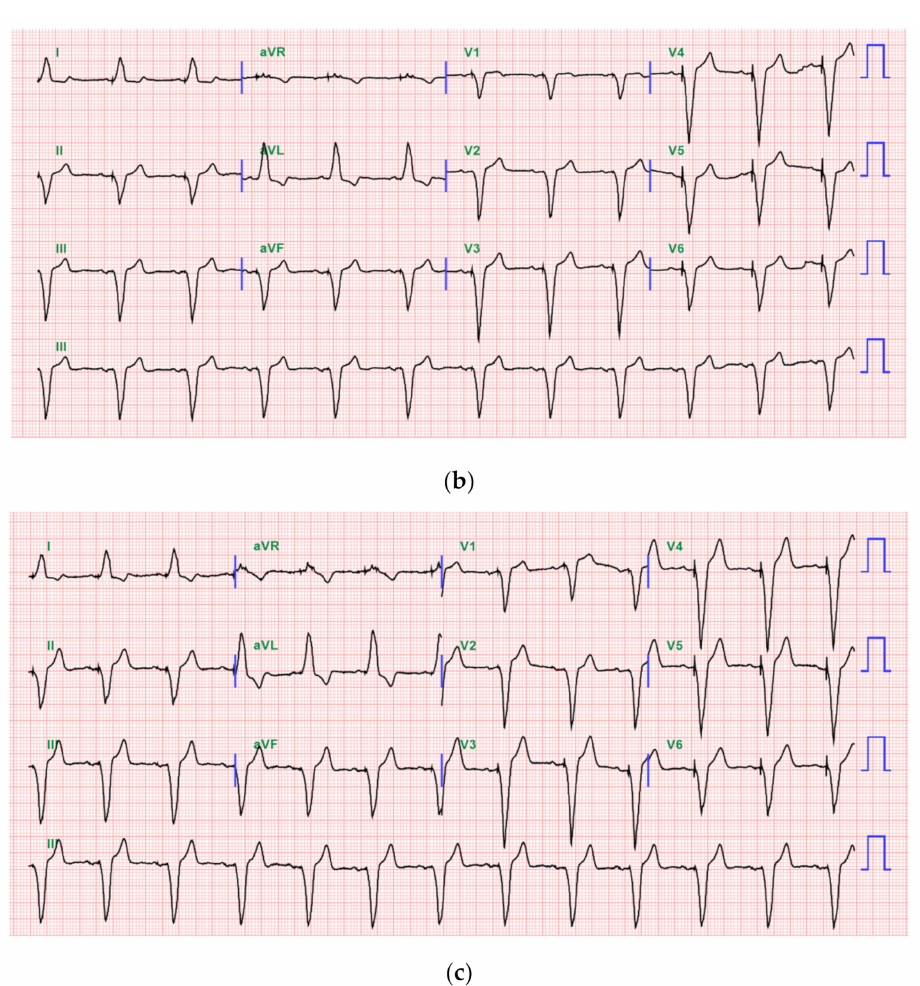
Figure 2. ( a ) 12 lead electrocardiogram (EKG) picture before spinal cord stimulation (SCS) trial. ( b ) 12 lead EKG picture in burst mode performed in recovery room after SCS trial. ( c ) 12 lead EKG picture in tonic mode performed in recovery room after SCS